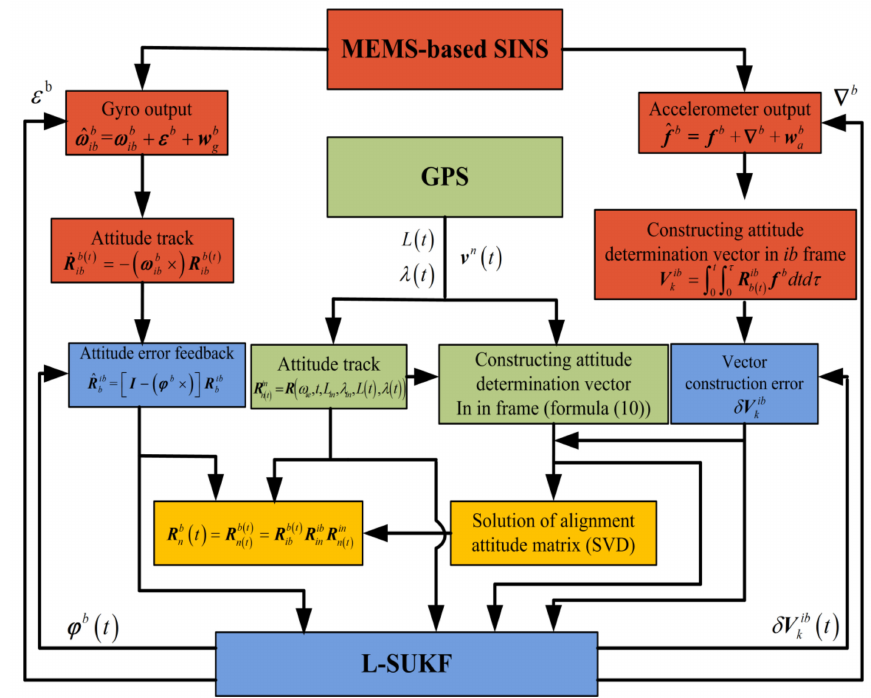
Figure 3. Overall flowchart of the proposed in‑flight alignment